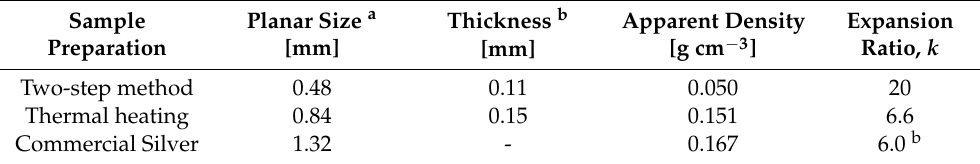
Figure 3. Variations of expansion ratios as a function of a H 2 O 2 treatment time at three different temperatures. Table 1. Summary on dimensions, apparent density and expansion ratio of the used eVMTs.